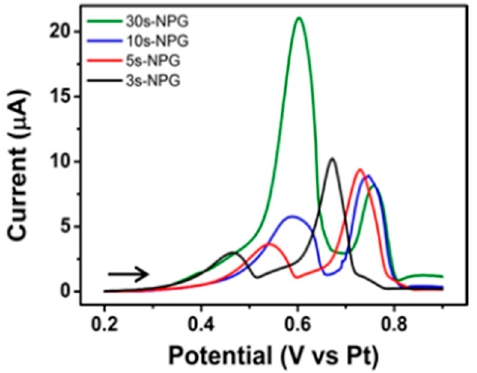
Figure 9. LSV at NPG-modified gold microdisc array electrodes at 10 mV s − 1 in Ventolin TM solutions (pH 4) containing 2 mg/mL salbutamol (as sulphate) in 0.0154 M NaCl and 0.05 mM H 2 SO 4 following 3, 5, 10 and 30 s deposition of Au 0.18 Ag 0.82 alloy and subsequent etching in nitric acid to yield NPG.